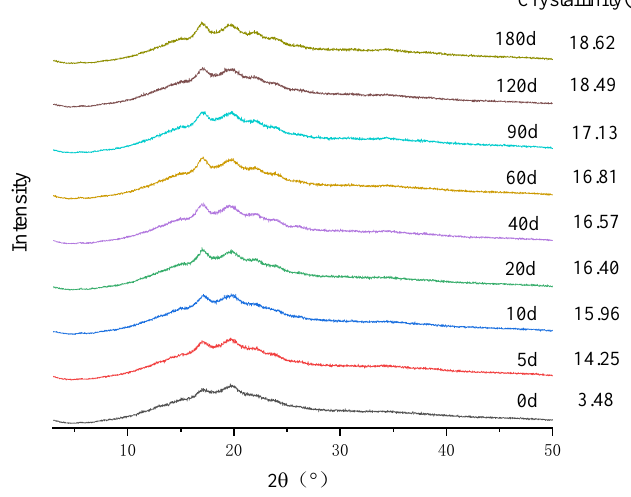
Figure 4. Changes in crystallinity of semi-dried rice noodles during